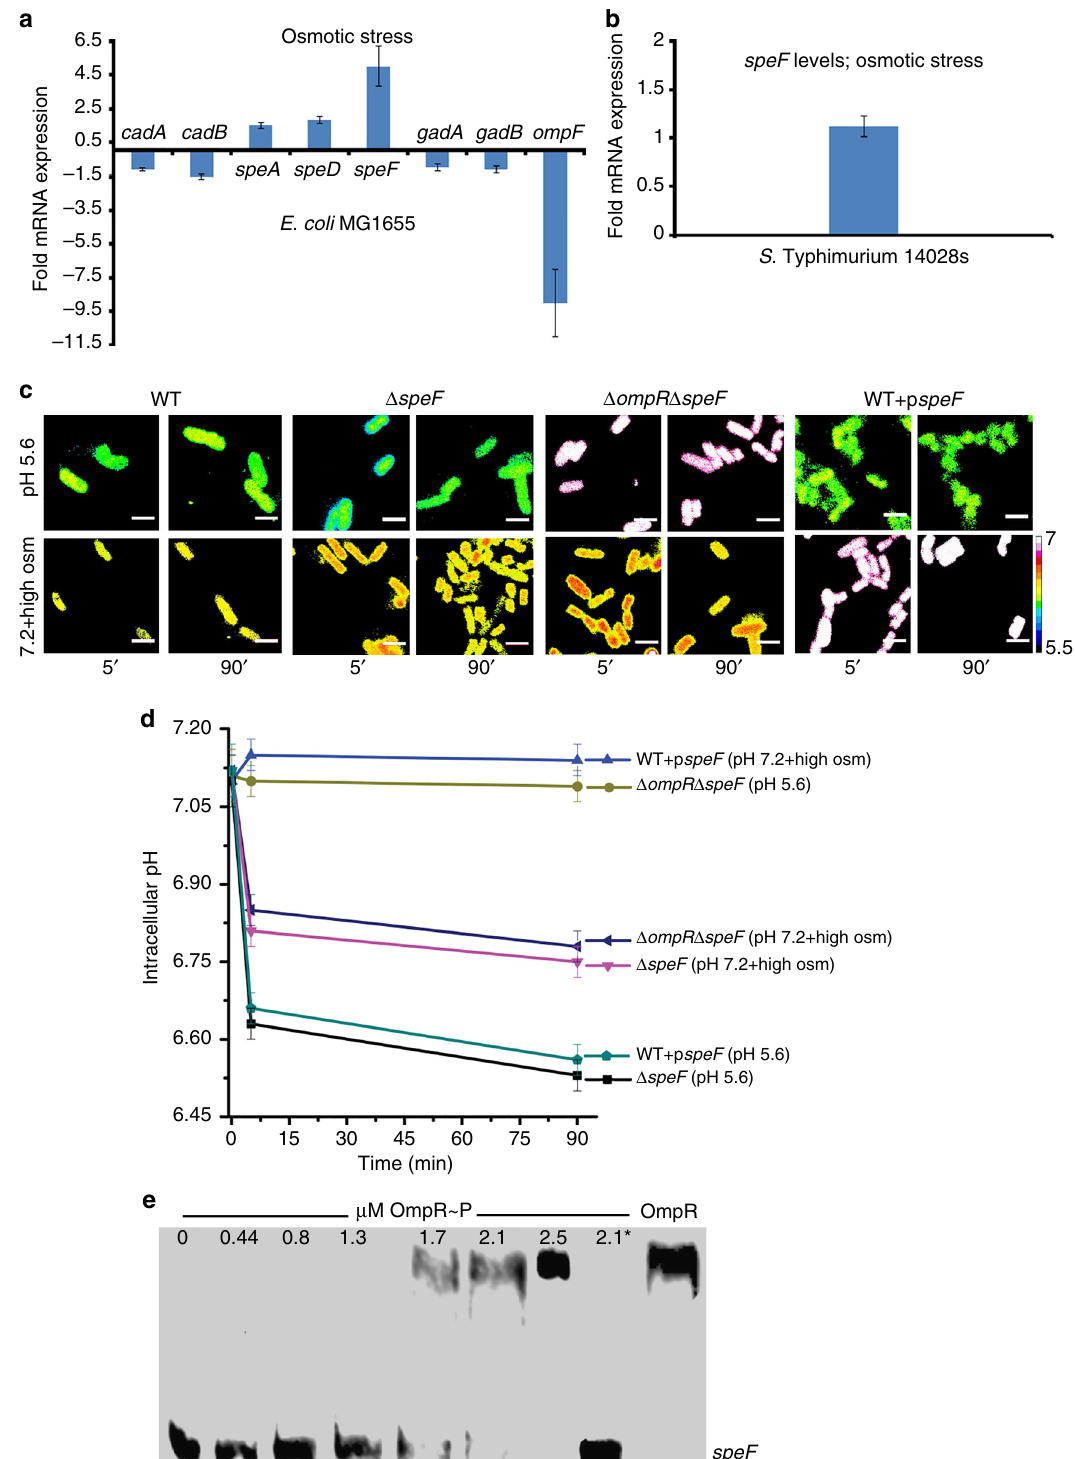
Fig. 4 OmpR represses speF to acidify E. coli during osmotic stress. a mRNA levels at pH e 7.2 containing 15% (w/v) sucrose of cadA, cadB, speA, speD, speF, gadA, gadB , and ompF genes were determined by qRT-PCR from wild-type and ompR null strains of E. coli MG1655. Fold expression changes were compared to the wild-type level. The error bars represent the mean ± s.d. ( n = 6). The ompR null strain showed increased transcription of speF at high osmolality. b speF mRNA level of an ompR null strain of S . Typhimurium was compared to the wild-type level at pH e 7.2 in the presence of 15% sucrose (w/v). c Representative R 488/440 images of wild type, an ompR null strain, an ompR / speF null strain, a speF null strain, and the speF over-expressed strain of E. coli grown at pH e 5.6 or pH e 7.2 in the presence of 15% (w/v) sucrose at the indicated time points. Scale bar, 3 μ m. d Plot of the R 488/440 ratios of various mutants of E. coli . The complete graph including all strains is in Supplementary Fig. 6. Data set is represented as the mean ± s.e.m. ( n = 3). e EMSAs were conducted with biotin end-labeled speF to detect OmpR – speF interaction. Lane 2.1* contained 100-fold excess unlabeled